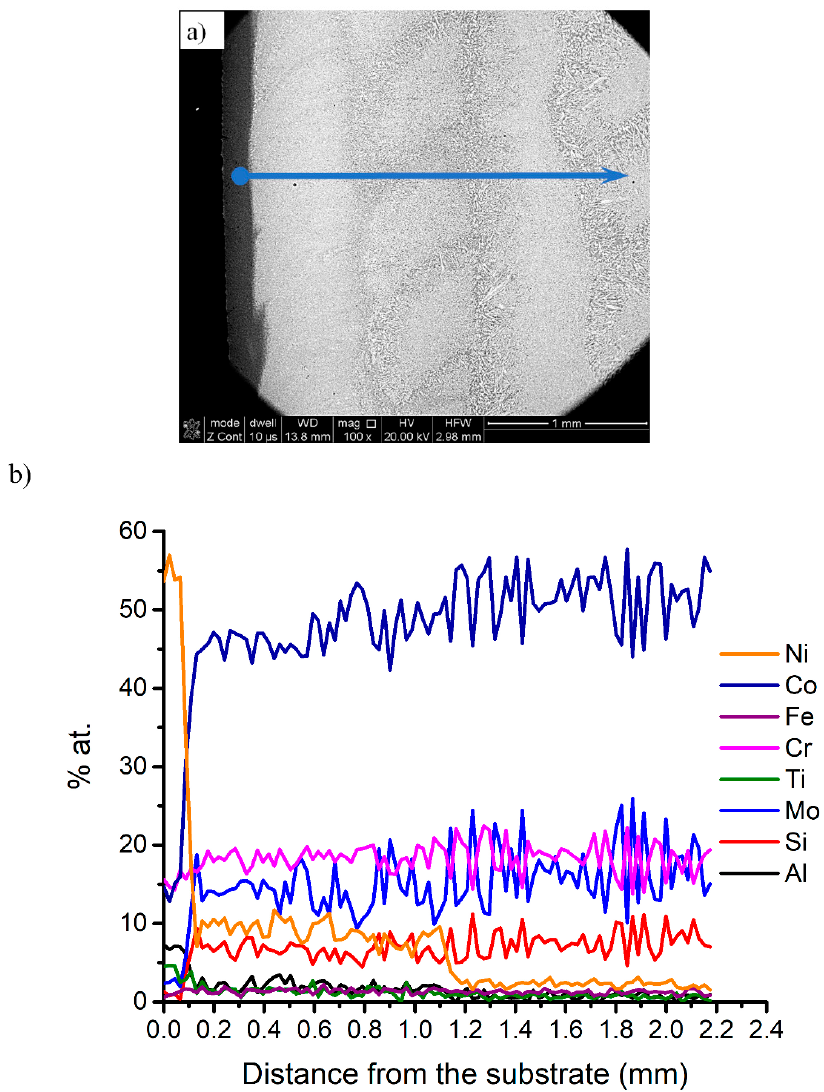
Figure 8. The results of the EDS linear chemical composition analysis of the T-800 coatings specimen 18: ( a ) a macrograph of the deposit with the arrow indicating the direction of linear EDS analysis. ( b ) The chemical content of the elements as a function of the distance from the substrate.